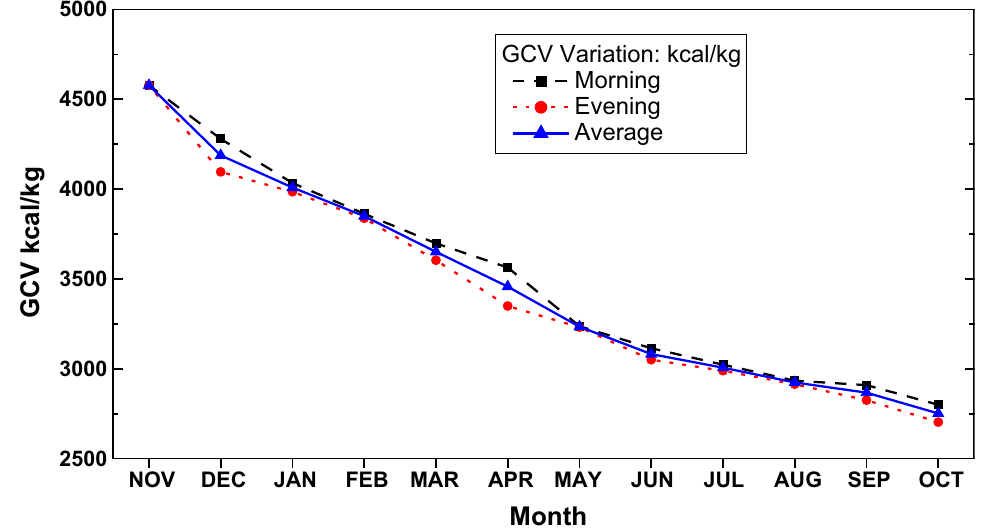
Fig. 4 Variation of GCV through the